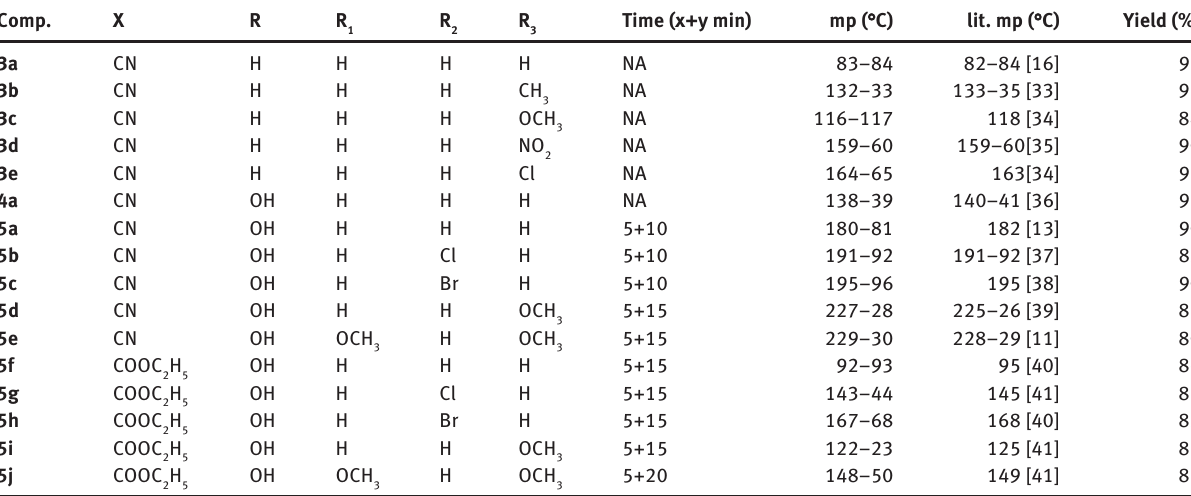
Table 2 Solvent free synthesis of benzylidenemalononitriles and 3-cyano/3-carbethoxycoumarins.